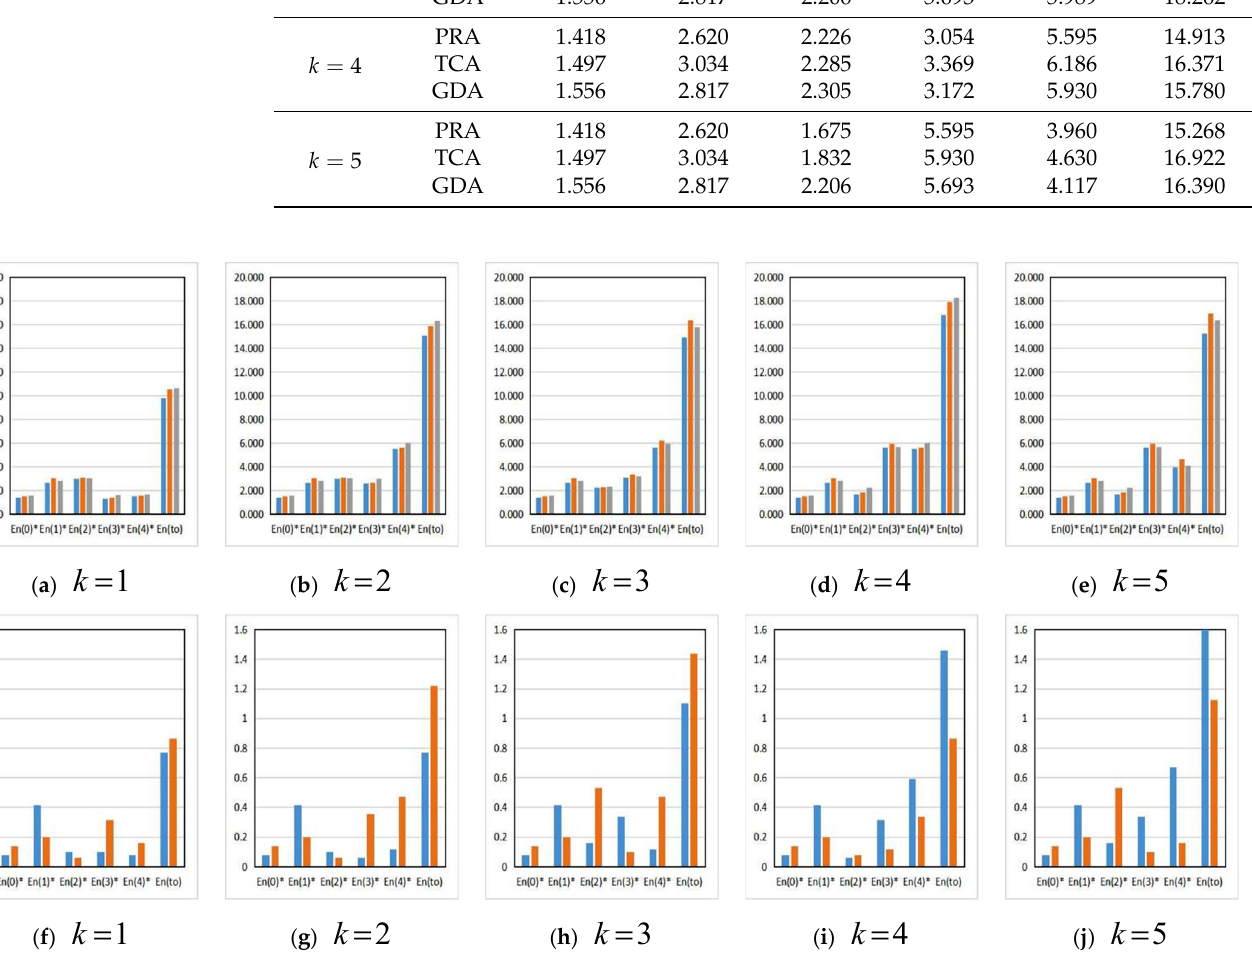
Figure 6. The emission volume and total emission volume of the three algorithms un- der the conditions of different cluster quantities, and the difference value comparison among the three algorithms of the emission volume.